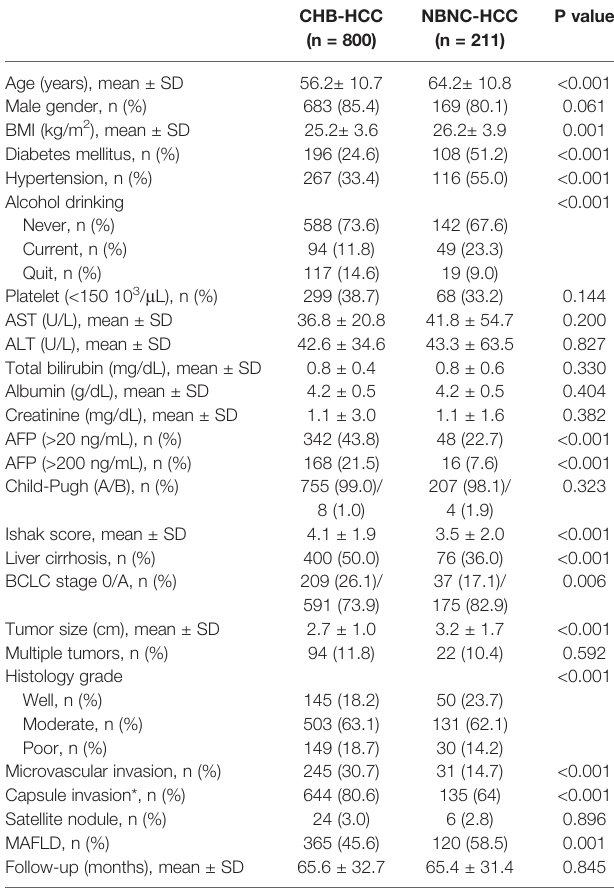
FIGURE 1 | Patient selection fl ow diagram.